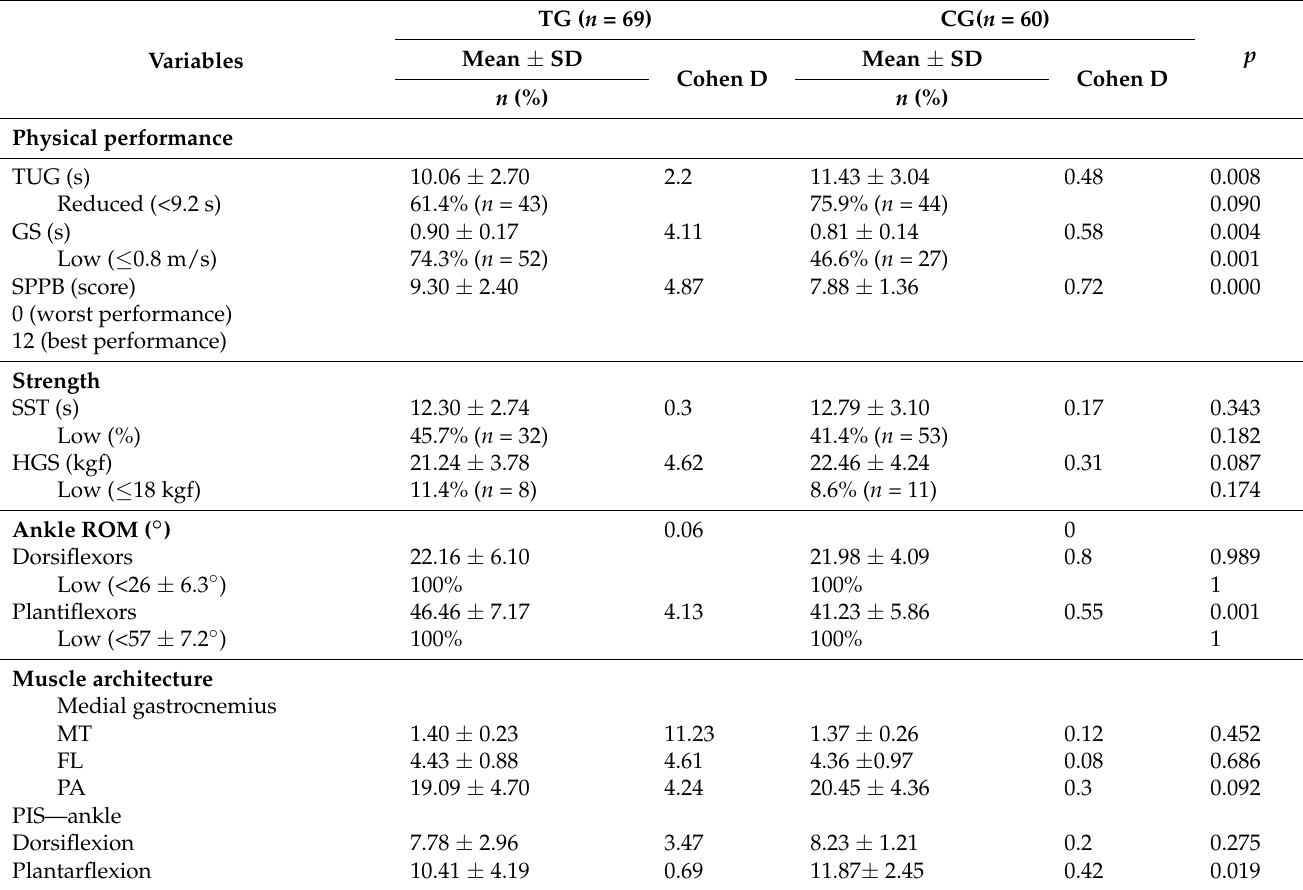
Table 2. Intrinsic factors for falls in the treatment and control